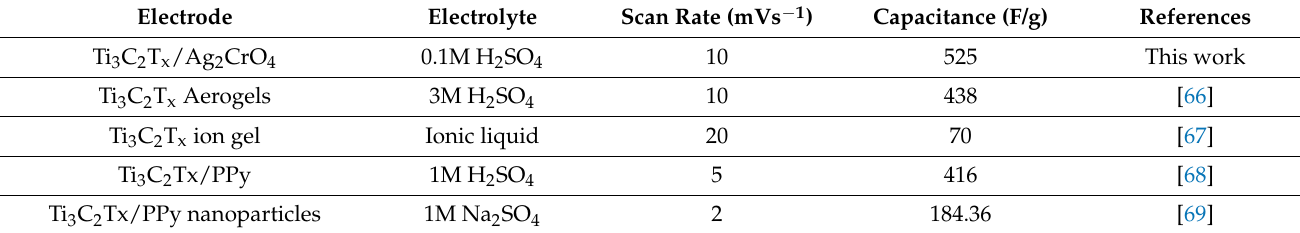
Table 4. Comparison of the specific capacitance with earlier MXene based nanocomposite electrodes.